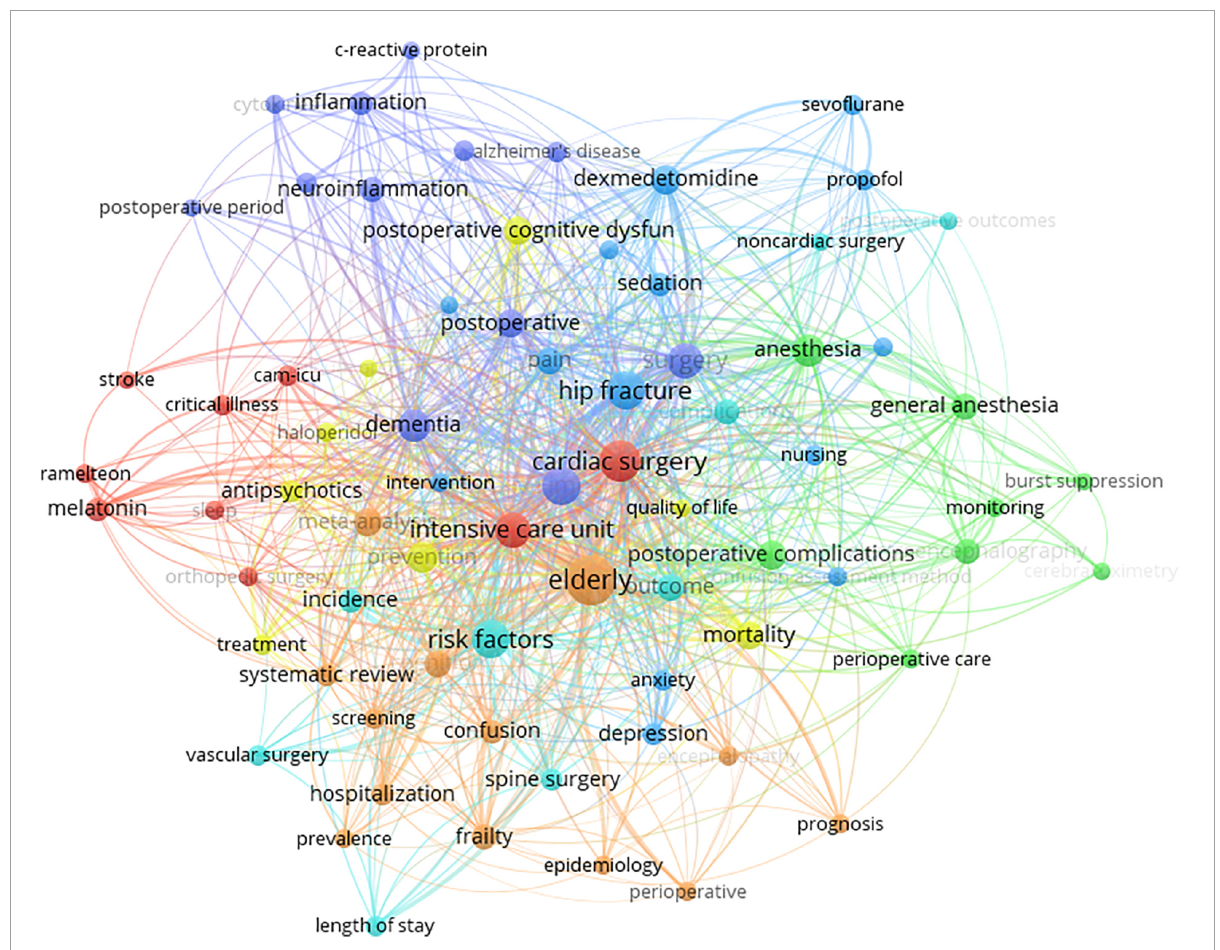
FIGURE7 Map of hotspots and keyword co-occurrence analysis regarding postoperative delirium